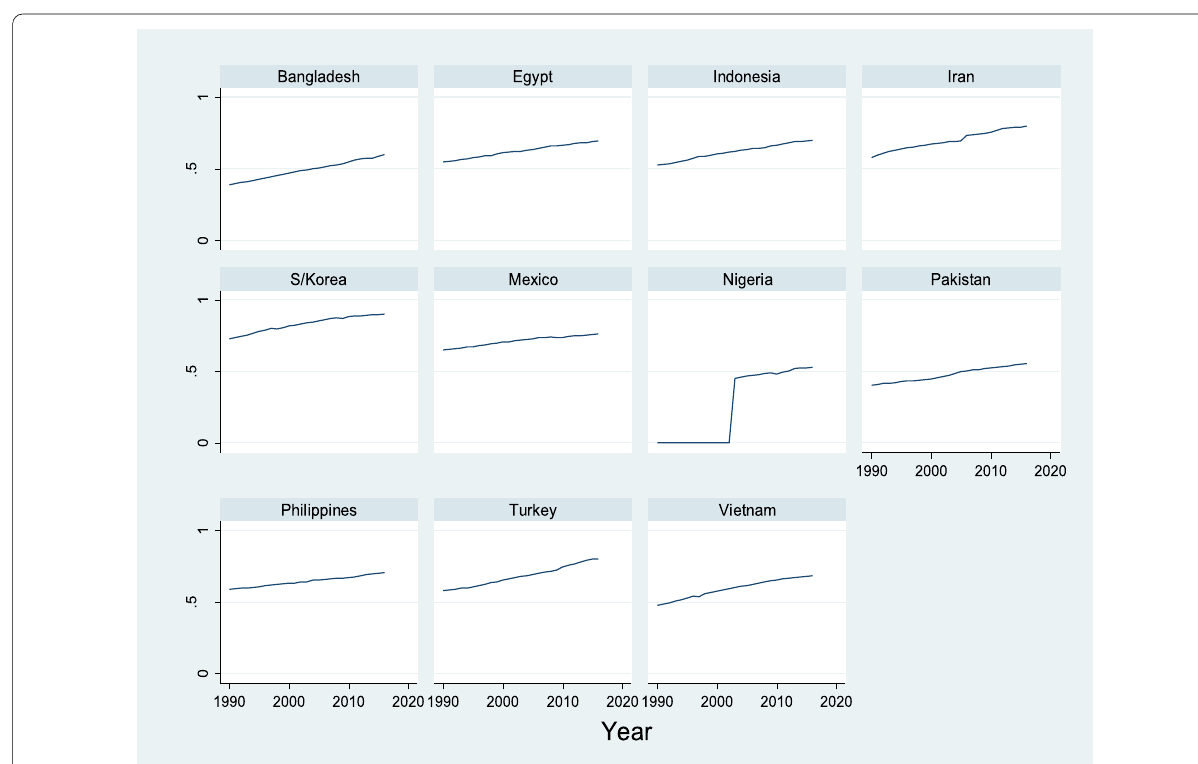
Fig. 7 Biocapacity in the individual N11 countries